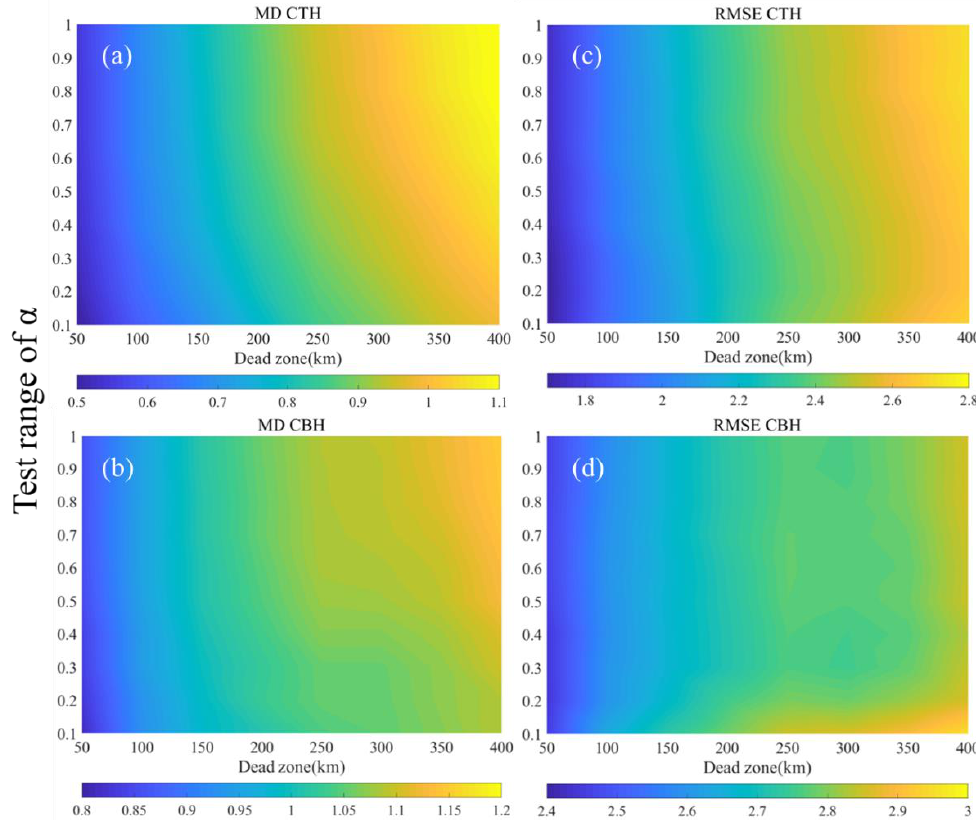
Figure 4. MD ( a , b ) and RMSE ( c , d ) of CTH and CBH between the original profiles and the reconstructed Figure 4. MD (a), (b) and RMSE (c), (d) of CTH and CBH between the original profiles and the profiles, changing with α and dead reconstructed profiles , changing with α and dead zone.